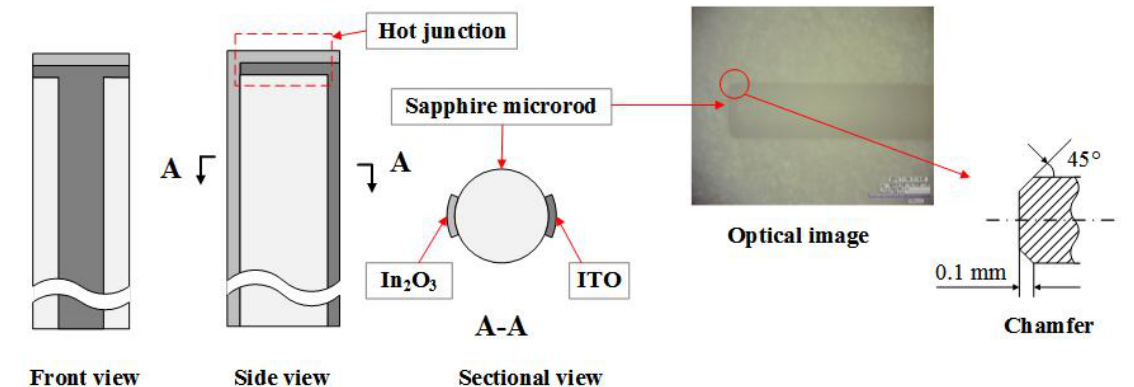
Figure 3. Structure of the sensor.